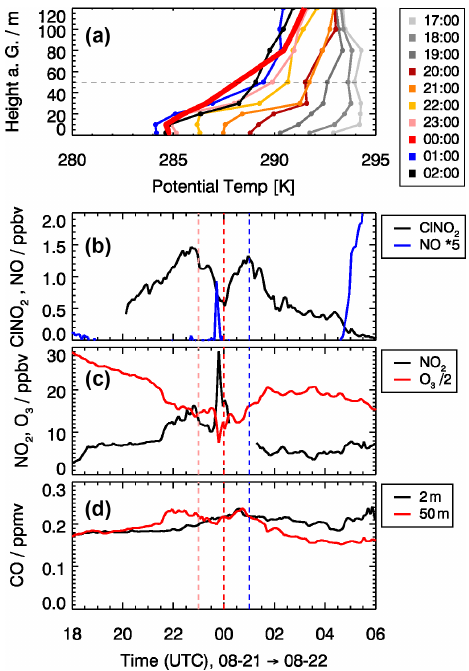
Figure 4. Impact of the vertical structure of air masses during the night from 21 to 22 August on observed trace gas concentrations. (a) Vertical profiles of the potential temperature derived from tem- perature measurements at different heights (2, 10, 20, 30, 50, 80, 100, and 120m). (b–d) ClNO 2 , NO, NO 2 , O 3 , and CO mixing ra- tios sampled at 50m height with the JULIAC-SAPHIR inlet system. CO mixing ratios were also measured at a height of 2m. Colors of the vertical lines correspond to colors of the vertical profiles of the potential